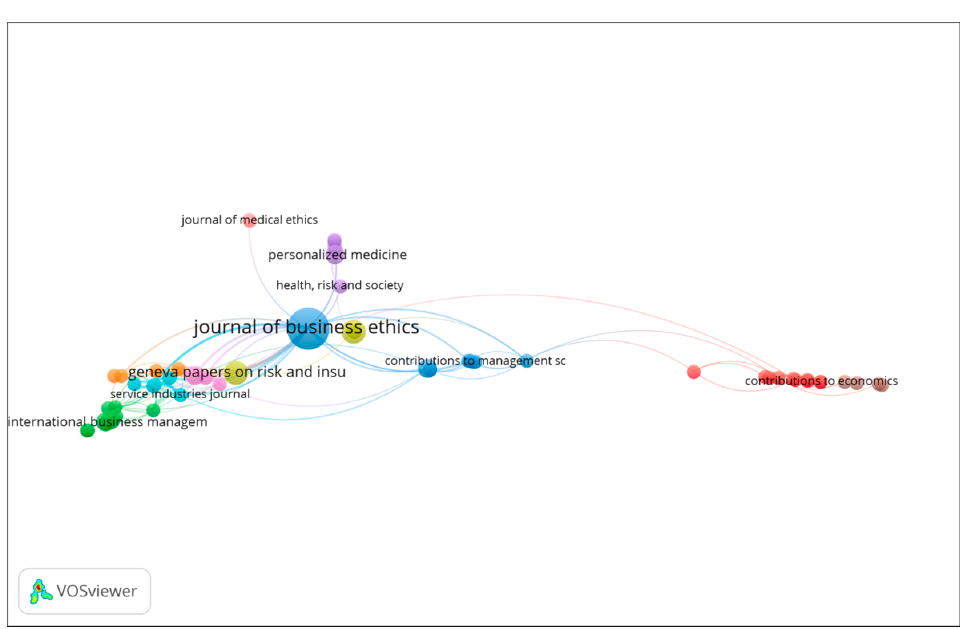
Figure 3. Cluster distribution of sources that published at least a document. Note: made by the authors. As Figure 3 illustrates, journals are divided into numerous clusters. These clusters are mainly connected with the central cluster of the Journal of Business Ethics . A group of small clusters in red and purple colors is poorly correlated with other journals.